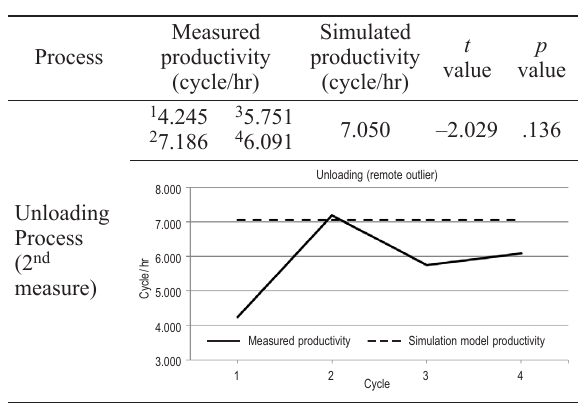
Fig. 7. Statistic distribution of the measured duration data for the activity of “ Preparing ” in the installing process before removing